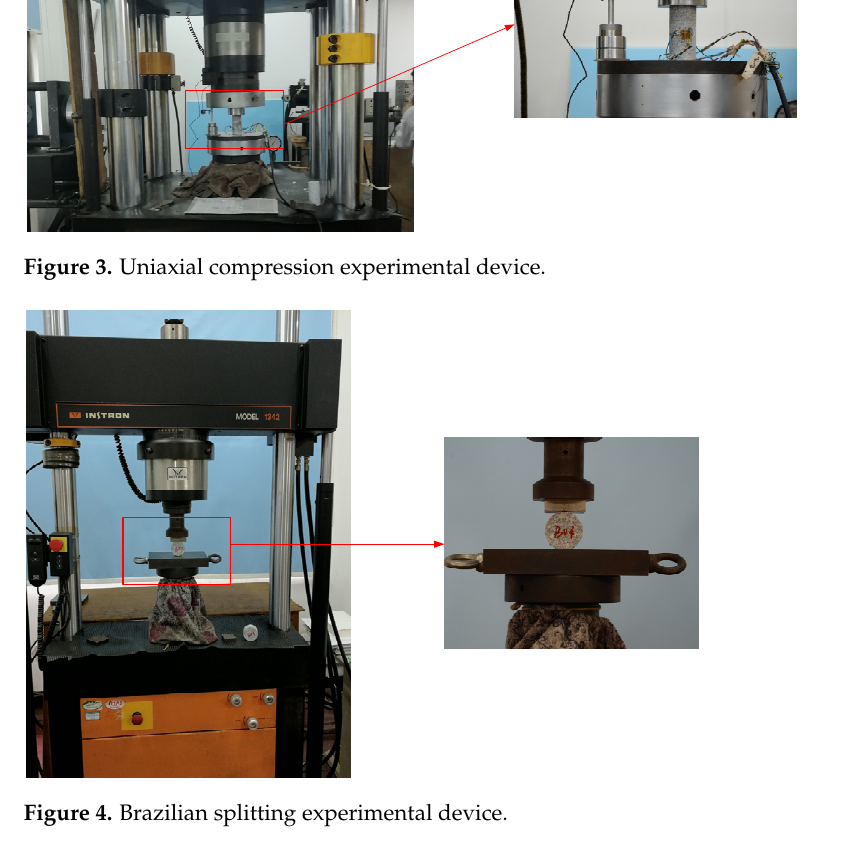
Figure 4. Brazilian splitting experimental device.